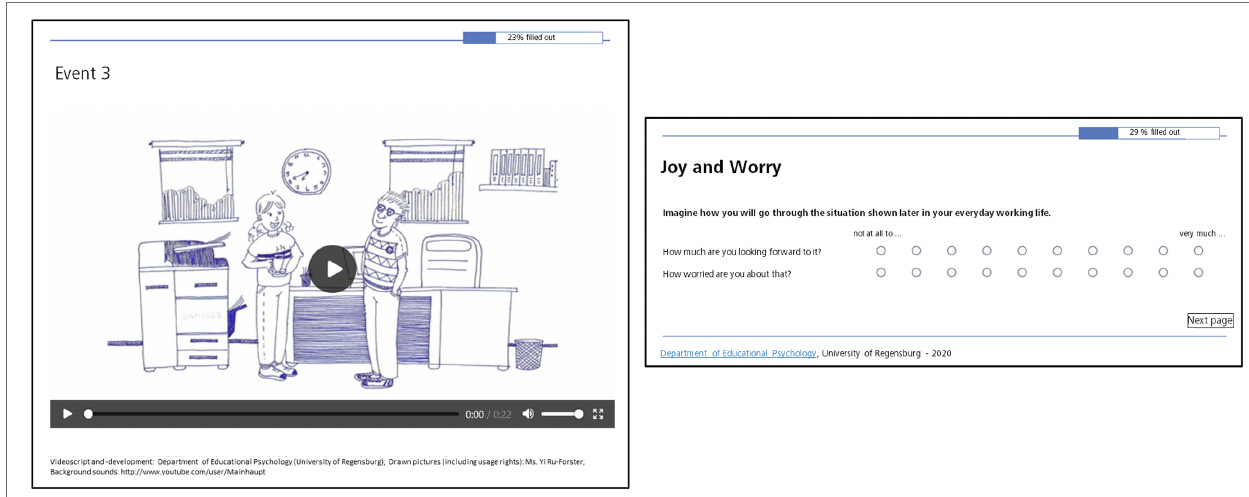
FIGURE 1 | Evaluation procedure. Student teachers evaluated 14 common events that could part of a typical everyday routine of a teacher and rated their expected emotional pleasure and discomfort for each of the events. Each event was visualized by a drawing (for an example, see left side of the figure) and accompanied by an oral description. Participants were asked to imagine how they will experience the respective event in the future, and to rate how much they are looking forward to experiencing this event in the future (i.e., expected emotional pleasure) and how much they are worried about experiencing this event in the future (i.e., expected emotional discomfort) on a 10-point Likert-scale ranging from 1 (“not at all”) to 10 (“very much”; see right side of the figure). Reproduced with permission from Yi Ru-Forster, who designed the materials specifically for this study. These are available on request by the corresponding